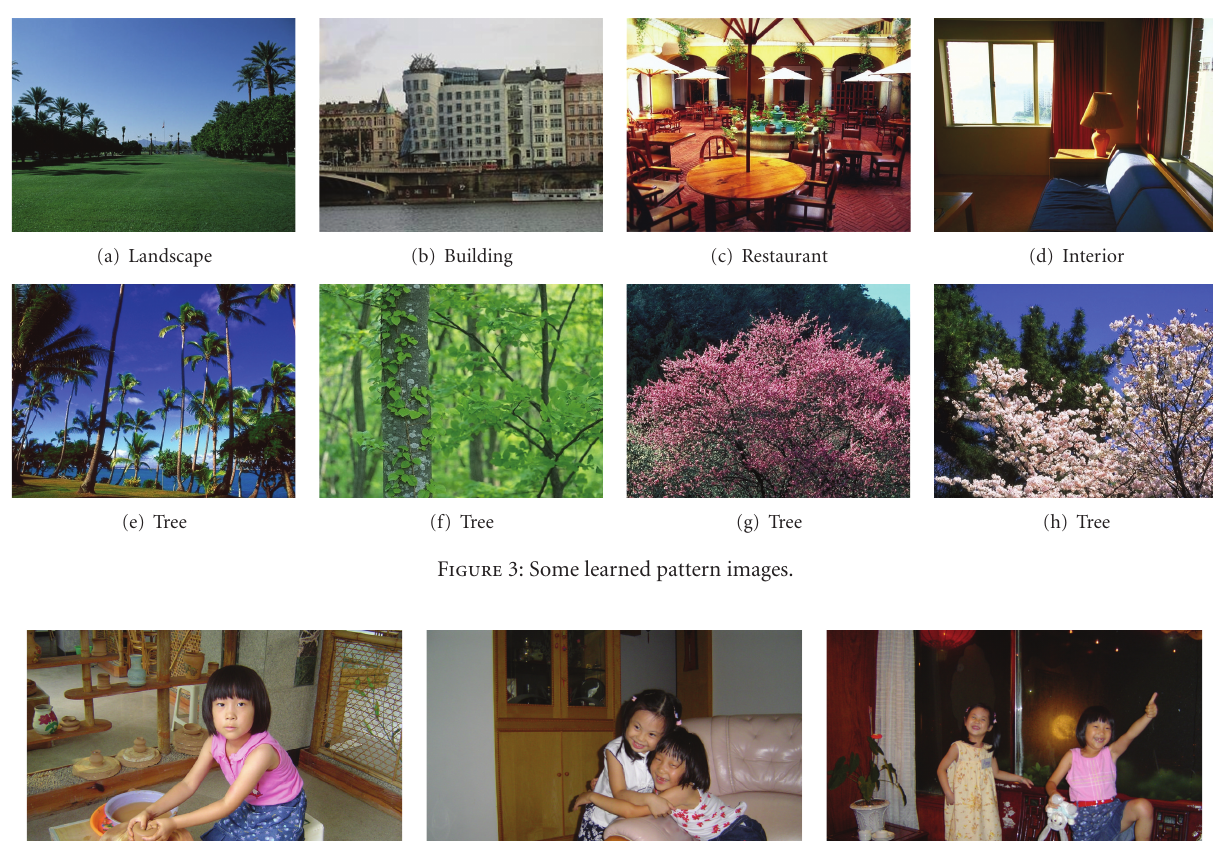
Figure 4: Images retrieved by furniture with